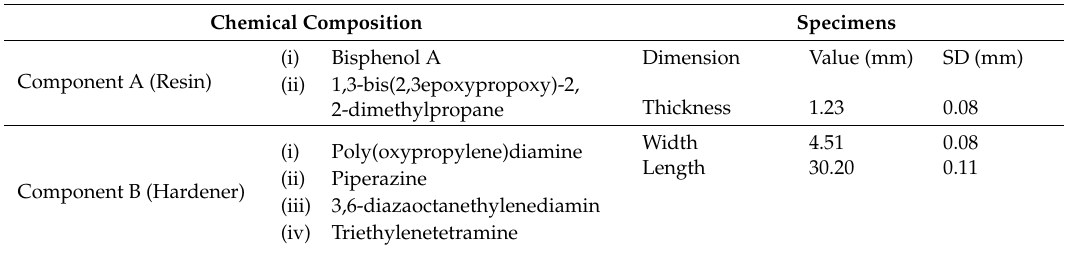
Table 1. Composition and dimensions of tested